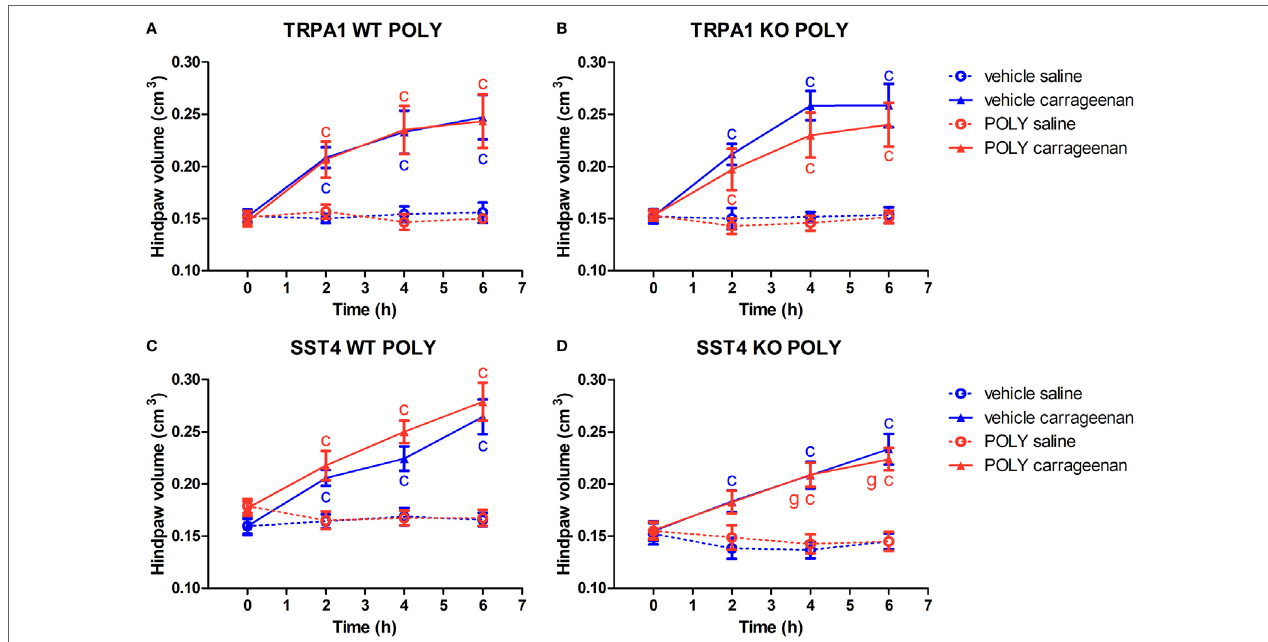
FigUre 3 | Sodium polysulfide (POLY; 17 µmol/kg, i.p.) does not affect paw swelling detected by plethysmometry in carrageenan-induced hind paw inflammation. Effect of POLY or vehicle treatment on paw swelling of either saline or carrageenan-treated (3% in 20 µL saline) hind paws of (a) transient receptor potential